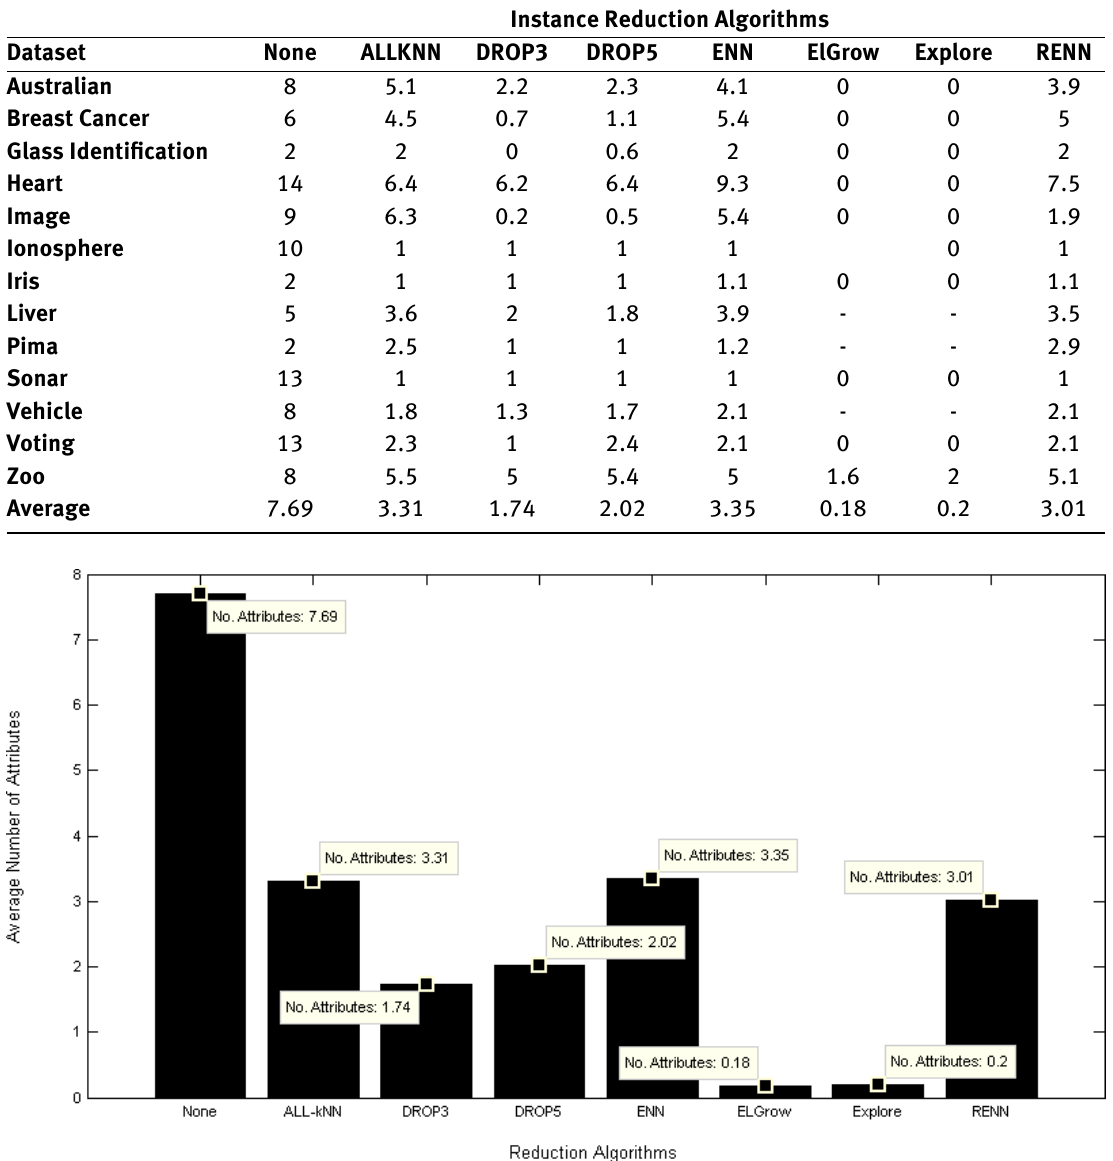
Table 5: Number of Attributes for unpruned trees with 0% noise ratio